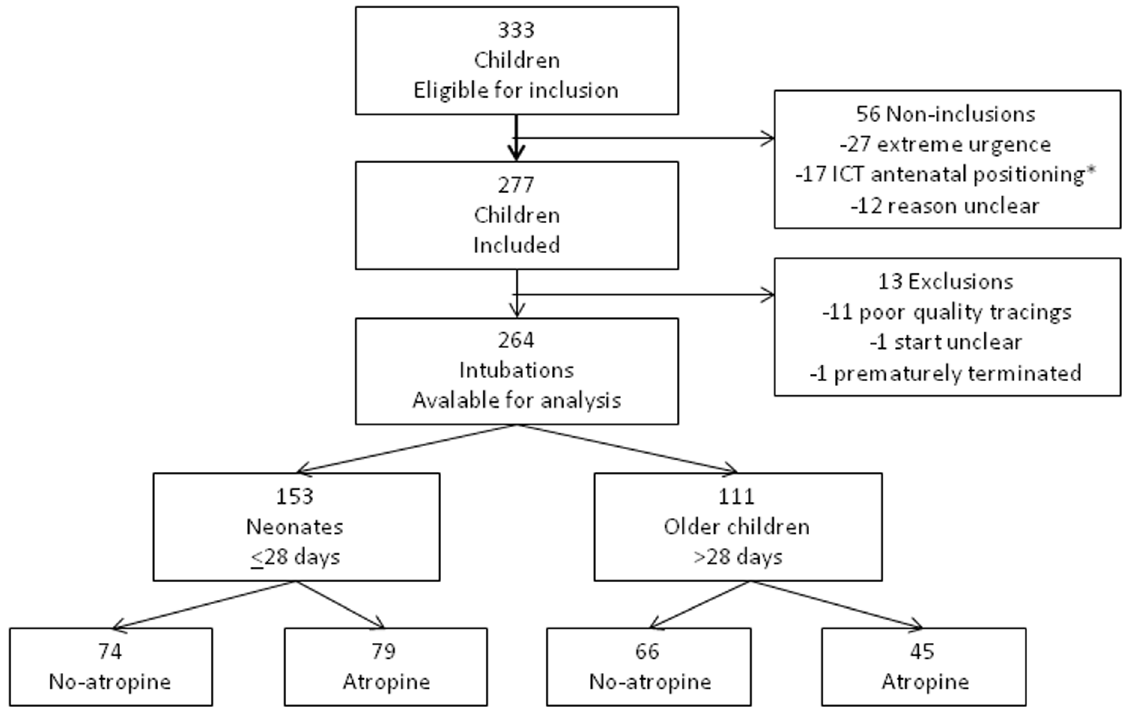
Figure 1. Flow-chart of inclusions, non-inclusions and exclusions. Neonates are # 28 days and older children . 28 days and less than 8 years. *ICT - Intensive Care Transport team positioned antenatally for premature births.